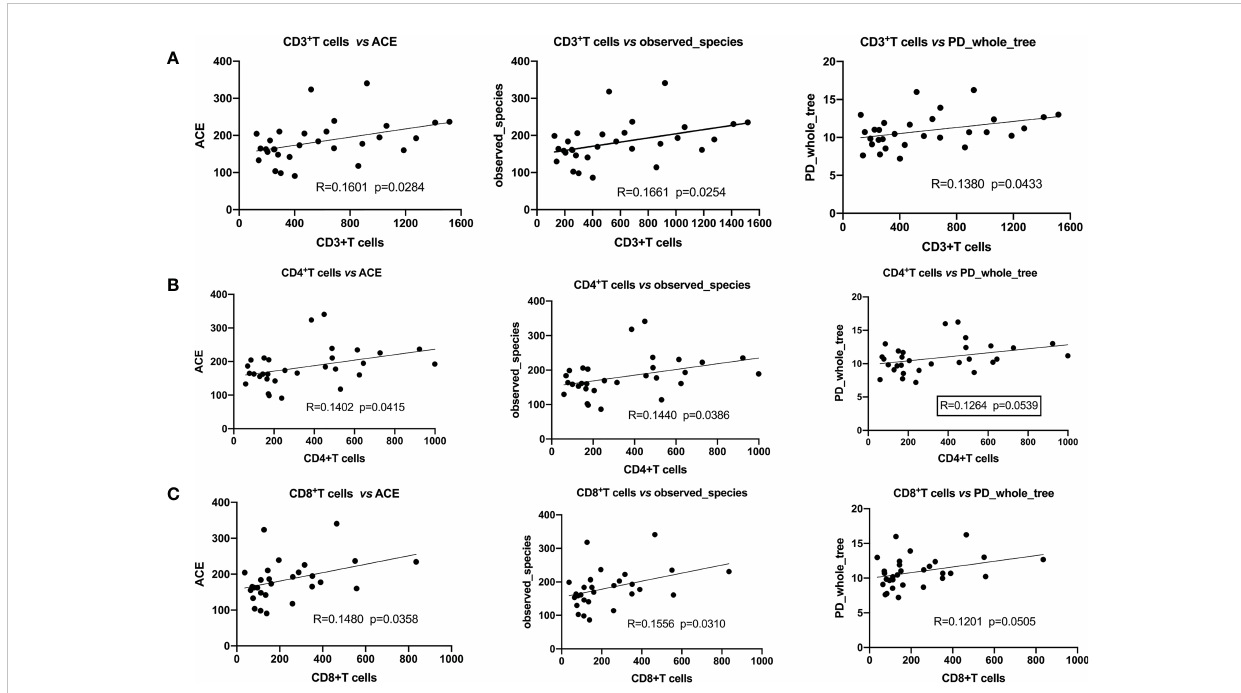
FIGURE 5 Pearson ’ s correlation indicated that a -diversity and immune cells were signi fi cantly positively correlated. (A) CD3+T cells with ACE, the observed_ species, PD_ whole_ Tree; (B) CD4+T cells with ACE, the observed_ species, PD_ whole_ Tree; (C) CD8+T cells with ACE, the observed_ species, PD_ whole_